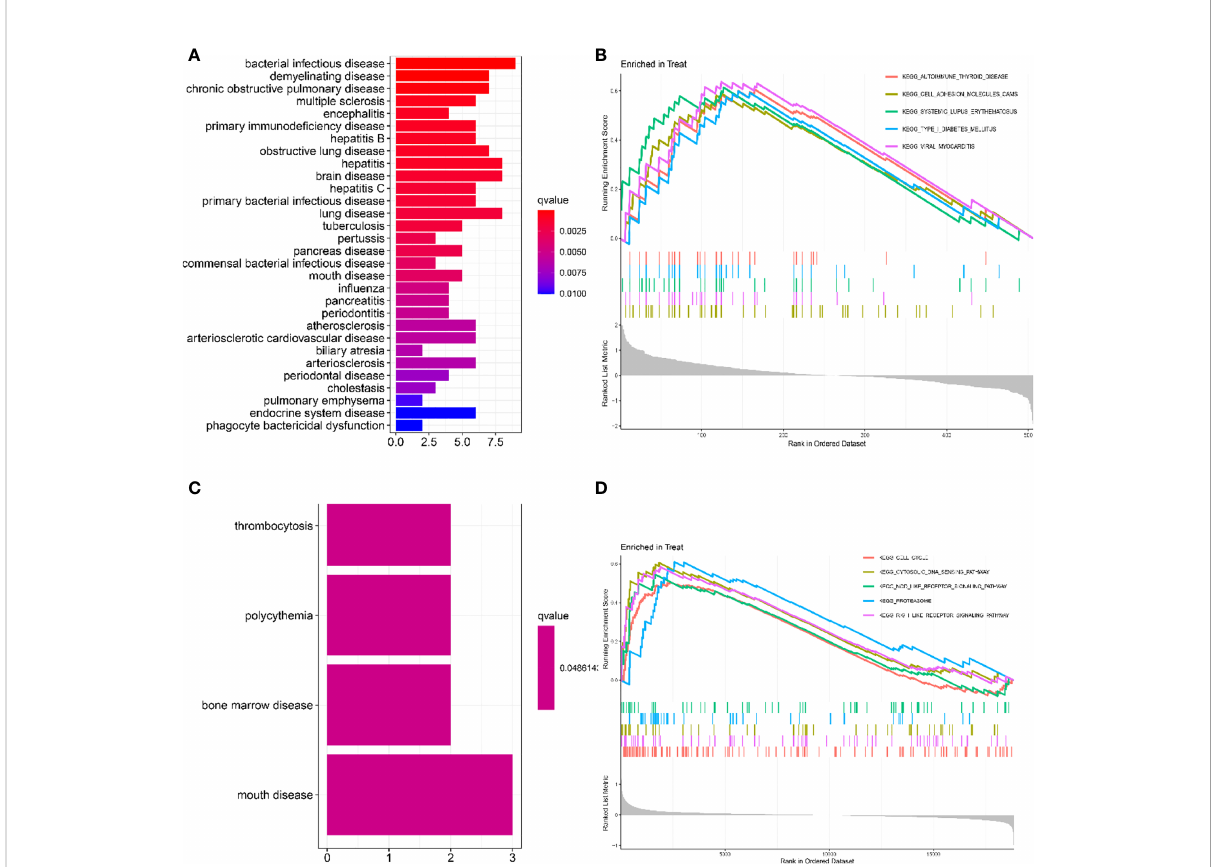
FIGURE 2 Functional enrichment analysis to identify potential biological processes by DO and GSEA. (A, C) Disease ontology (DO) enrichment analysis of DEGs. The vertical coordinate represents the name of the disease, the horizontal coordinate represents the number of genes enriched on the disease, and the color represents the signi fi cance of the enrichment. The redder the color, the more signi fi cant DEGs enrichment on the disease. (B, D) Gene set enrichment analysis (GSEA) is used to see which pathways were active in the healthy control or LN group. It consists of three main parts: The fi rst part is the enrichment score line graph: it shows the trend of the cumulative enrichemnt score (ES) value when the analysis calculates the ES value of each gene in the gene set along the ranked list (gene list). The score at the highest peak is the ES value for that gene set. The main focus is on the peaks, with peaks at the top and ES > 0 indicating that they are active in the set; peaks at the bottom and ES < 0 indicating that they are inactive in the set. The fi ve colors represent each of the fi ve pathways (the top 5 in order of corrected p-value). The second part, with lines marking where members of the gene set appear in the gene sorting list, the pathways to which the different colors belong. The third part: the signal-to-noise ratio for each gene is shown as a gray frame plot. The horizontal coordinate represents the ranking in the ordered data set, and the vertical coordinate represents the Running Enrichment Score. (A, B) Kidney tissue; (C, D) Peripheral